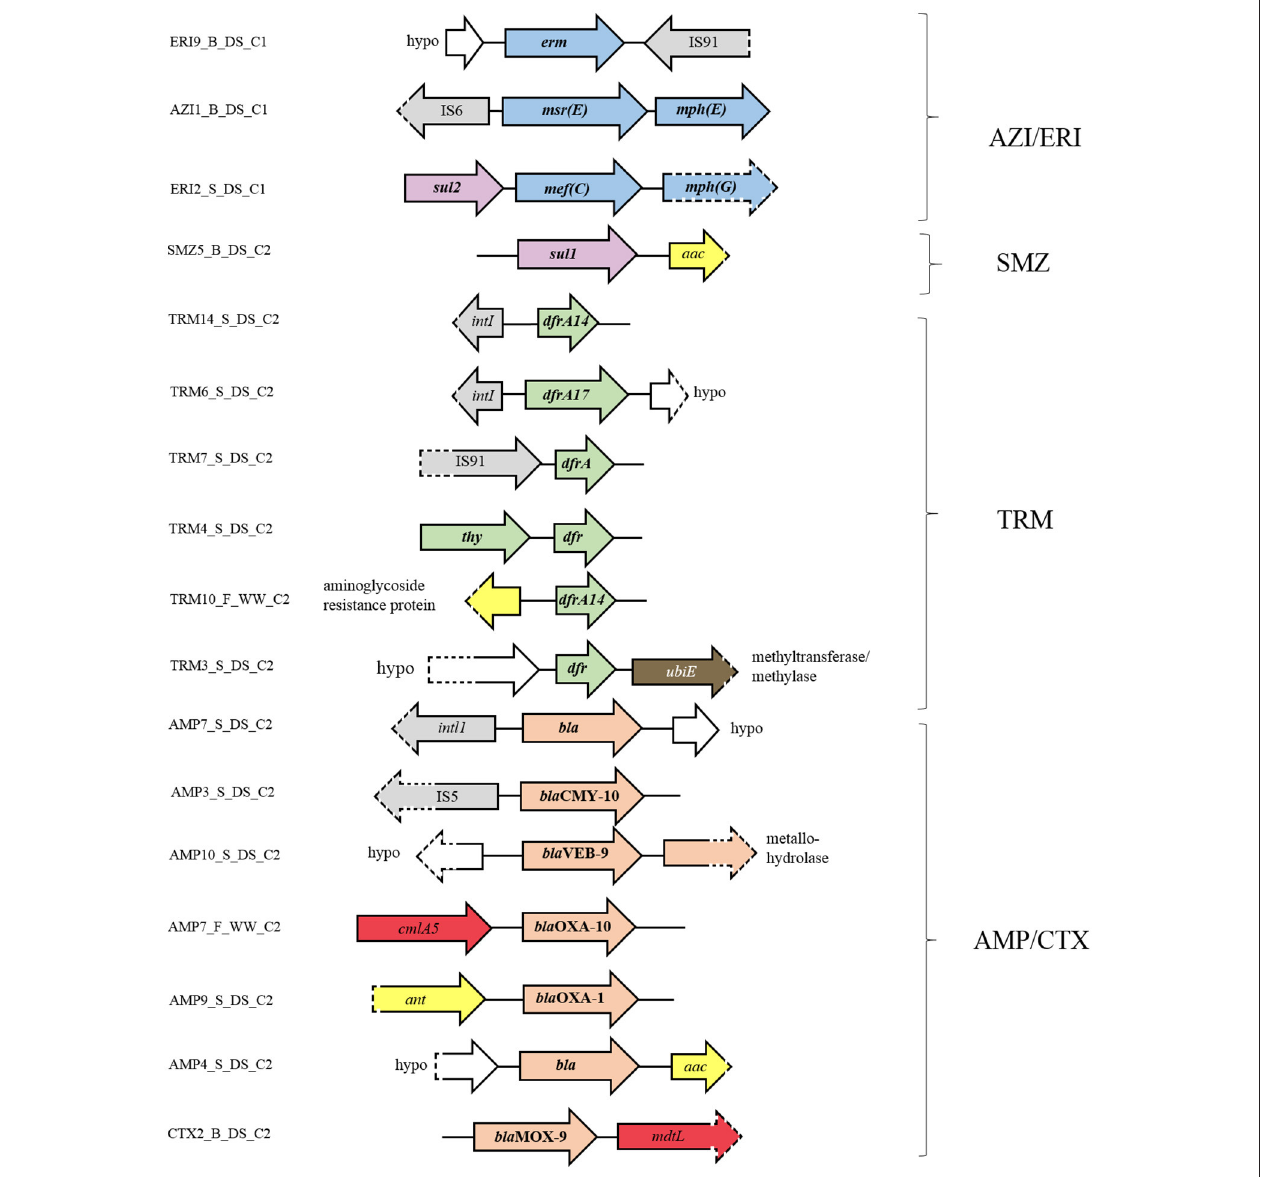
FIGURE 4 | Genetic context of the resistance genes and flanking ORFs identified in the metagenomic libraries. Orientation of the annotated genes in comparison to their genetic context is given by the direction of the arrow. ORFs involved in antibiotic resistance to macrolides are shaded in blue, sulfonamides in purple, trimethoprim in green, beta-lactams in pink, aminoglycosides in yellow, chloramphenicol in red, and D-cycloserine in brown. ORFs connected to gene dissemination are shaded in gray and ORFs annotated as hypothetical proteins in white. Dashed parts of arrows indicate incomplete